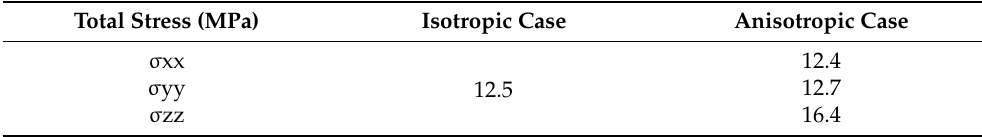
Table 2. In-situ stresses for analyzed cases